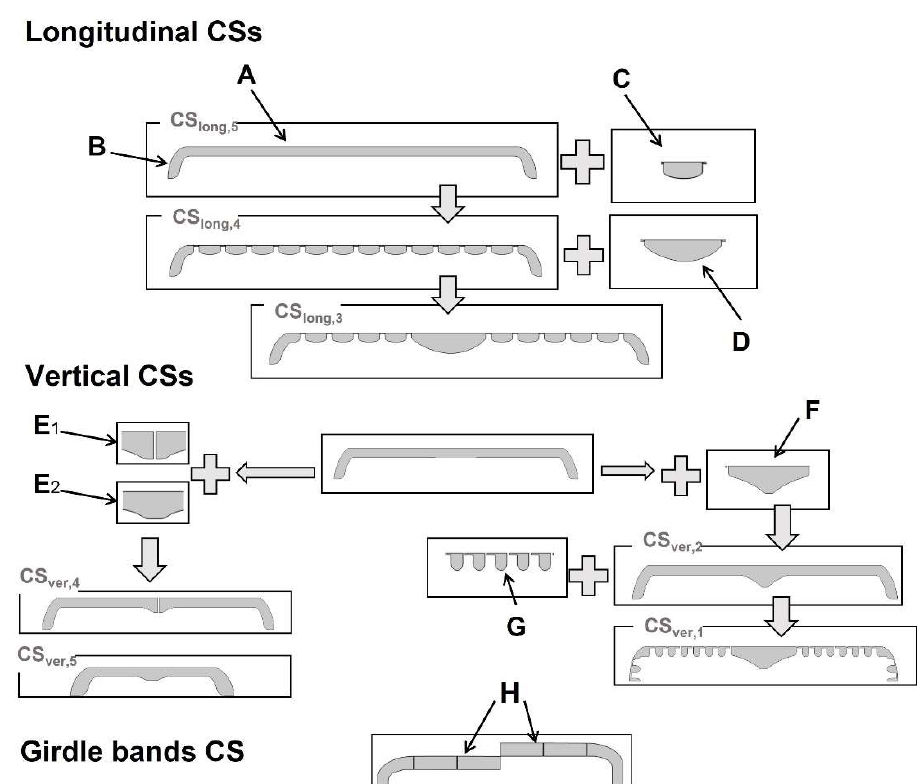
Figure 2. A schematic diagram illustrates the idea of “building” the CSs by adding different optical components. ( A ) A thin-slab element representing the valve face without areolae or other components, ( B ) a curved, fiber-like structure representing the mantle, ( C ) a grid unit of lens-like structure representing a costa, ( D ) lens-like structure representing the nodule in longitudinal CSs, ( E 1 and E 2 ) increased thickness representing the sternum with and without the raphe slit, respectively, ( F ) triangular-like structure representing the nodule in vertical CSs, ( G ) the grid-like structure in vertical CSs, representing the consecutive areolae within a stria, ( H ) four rectangular, fiber-like structures representing girdle bands.